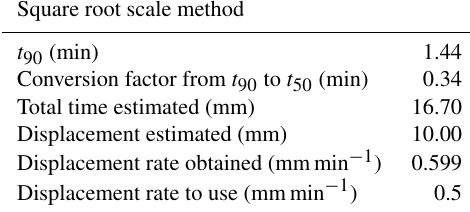
Table 1. Direct shear test results.